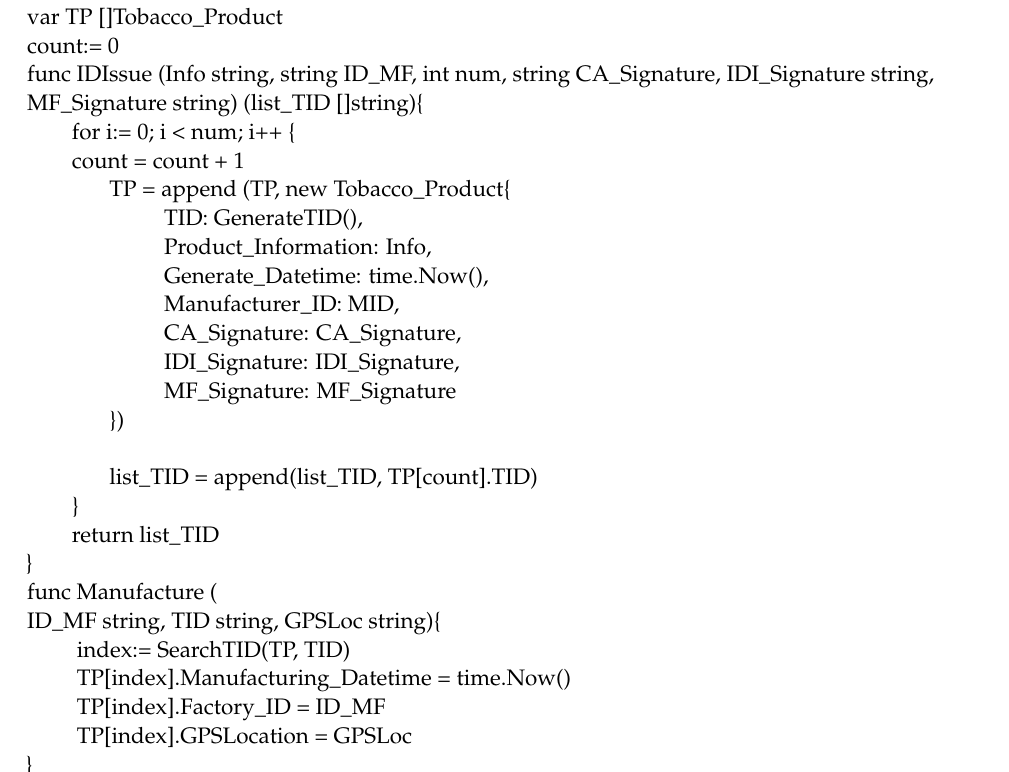
Algorithm 3. Chaincode of issuing ID and manufacture of the proposed